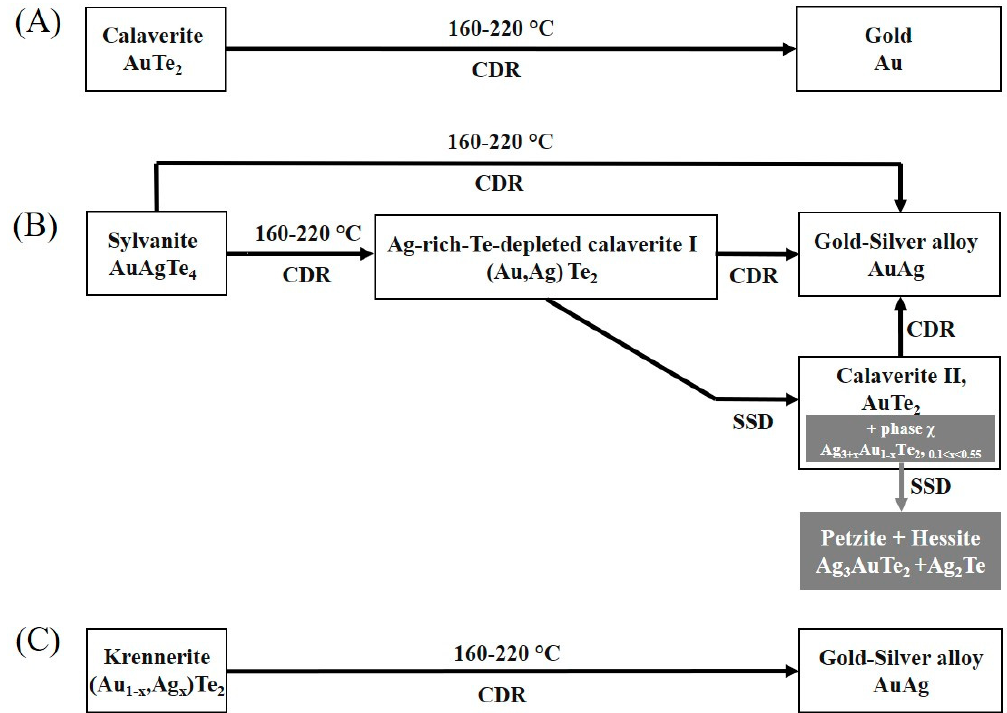
Figure 5. Overview of the proposed reaction paths of the hydrothermal reaction for calaverite ( A ), sylvanite ( B ) and krennerite ( C ). CDR stands for coupled dissolution reprecipitation and SSD stands for solid state diffusion.